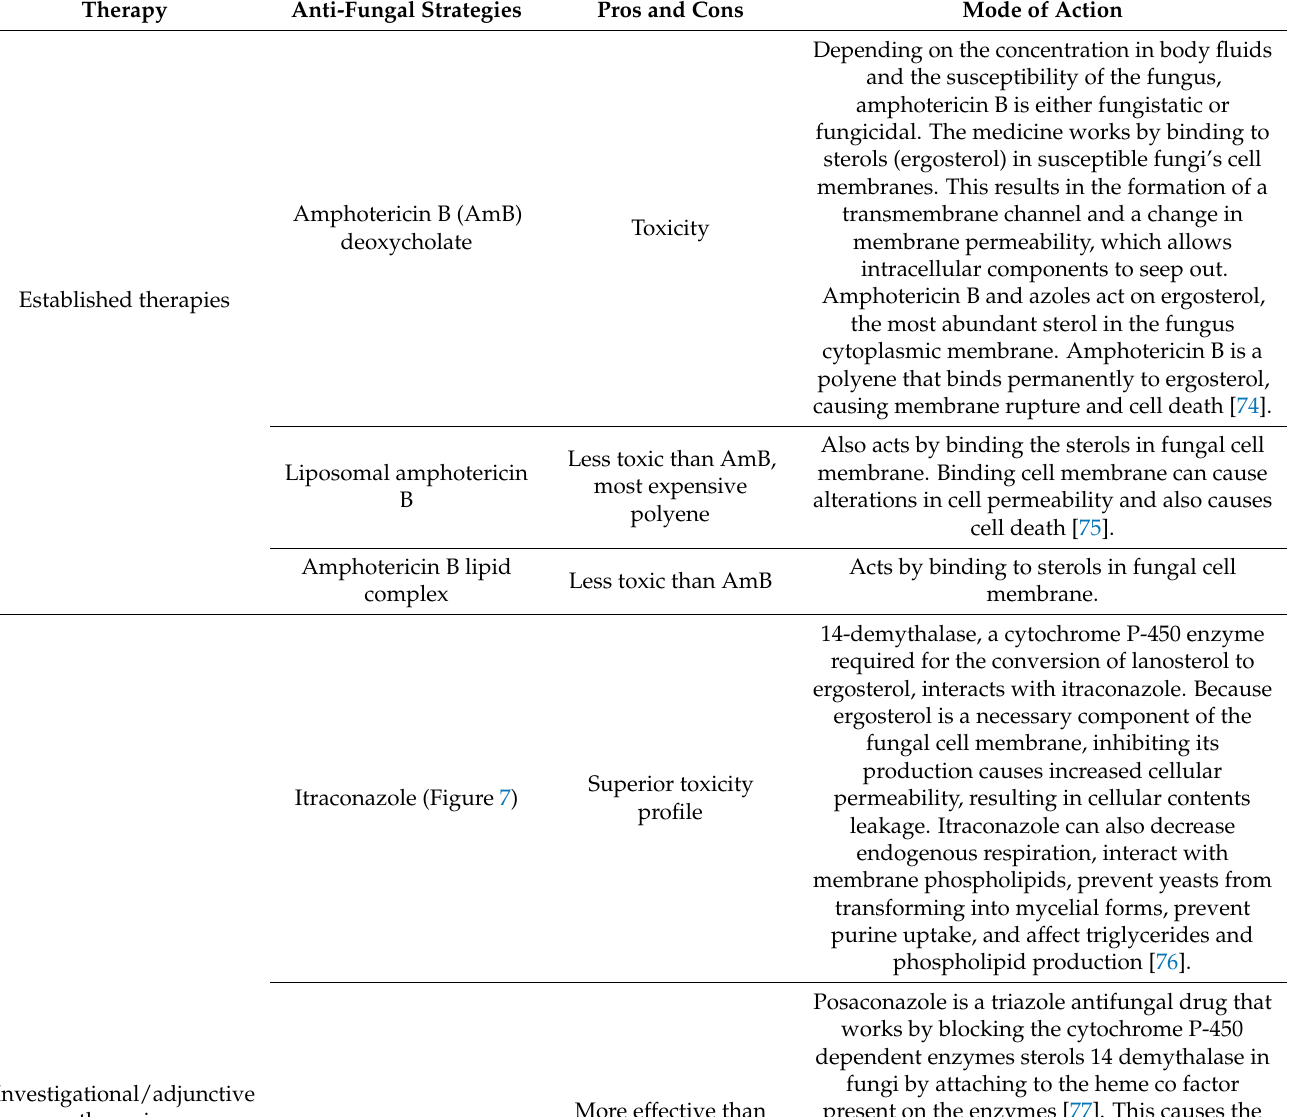
Table 2. Anti-fungal strategies for